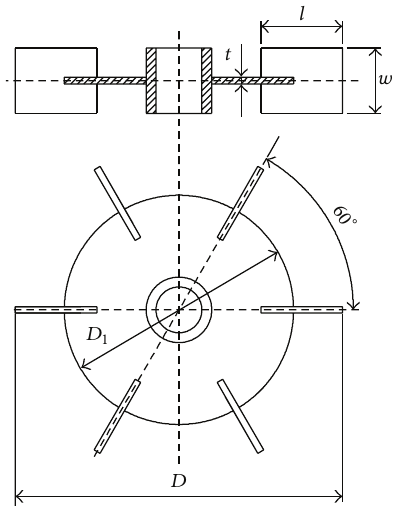
Figure 5: Sketch of Rushton turbine impeller, 𝑤/𝐷 = 0.2 , 𝐷 1 /𝐷 = 0.75 , and 𝑙/𝐷 = 0.25 .